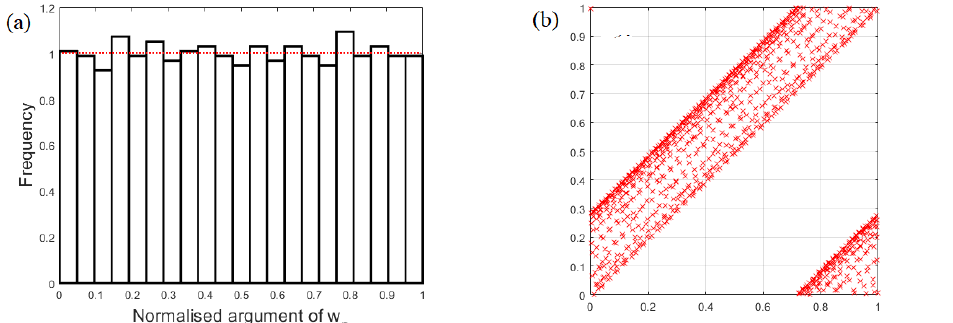
Figure 5. ( a ) Histogram of normalised arguments ˜ θ n , n = 0, . . . ,500 by (10), against the uniform density (dotted line); ( b ) Plot of ( ˜ θ n , ˜ θ n + 1 ) (crosses), n = 0, . . . ,500, for the sequence in Figure